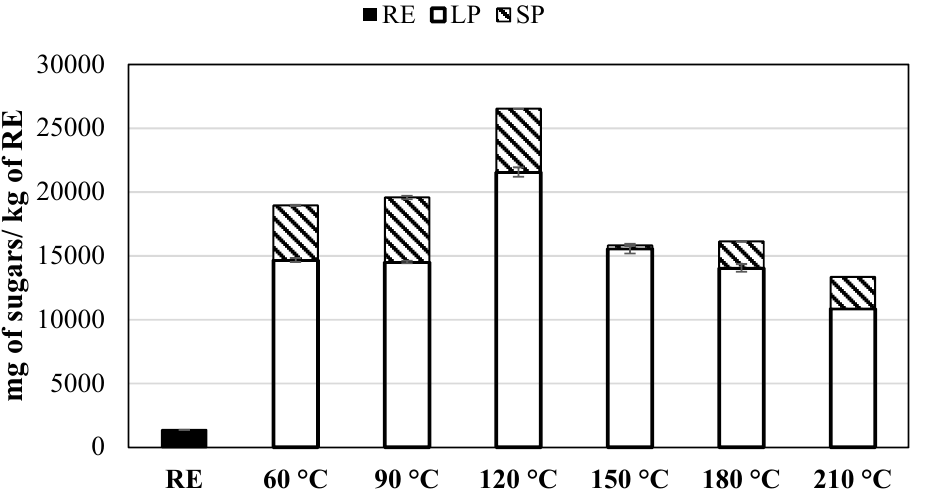
Figure 1. Milligrams of sugars (D-glucose equivalents) per kilogram of extrudate for untreated raspberry extrudate (RE) and different fractions obtained after the hydrothermal treatments.